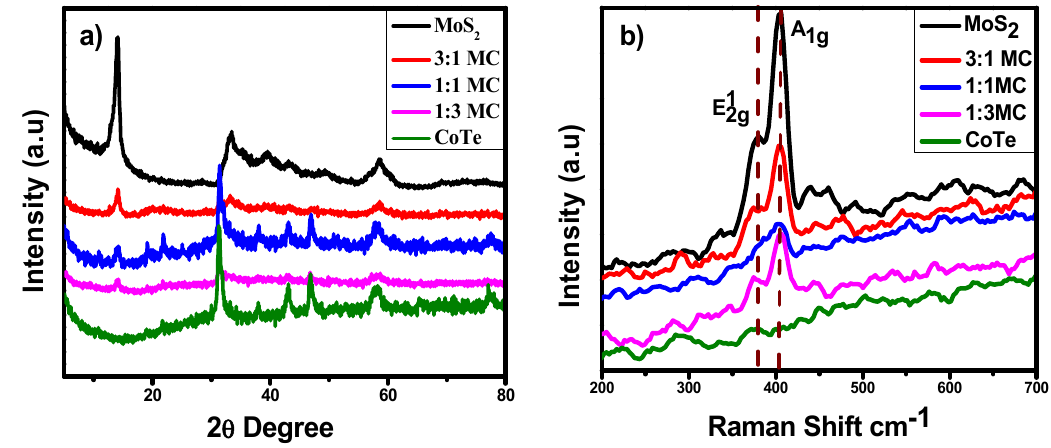
Figure 1. ( a ) X-ray di ff raction pattern of CoTe, MoS 2 , 1:3 MoS 2 / CoTe (MC), 1:1 MC, 3:1 MC. ( b ) Raman shift values of MoS 2 , CoTe and their composites.